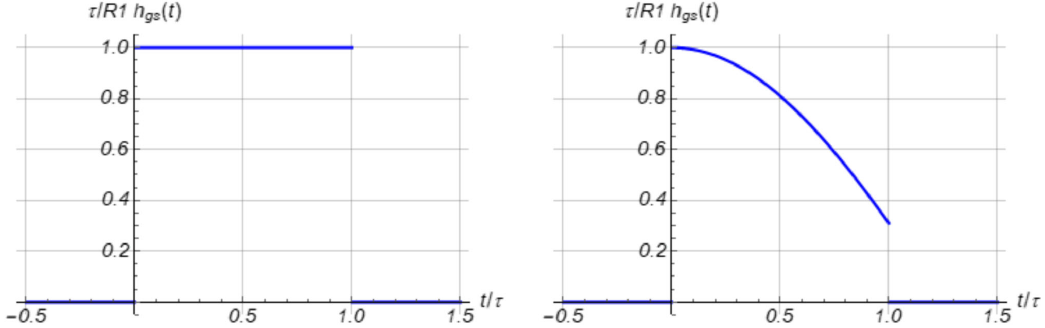
t Þ normalized. For Δ f 0 τ ¼ 0 (left) and Δ f 0 τ ¼ 0 . 2 gs ð